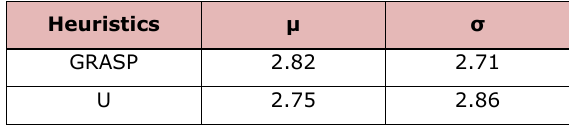
Table 7. “ μ and σ of D by procedure”. Source: